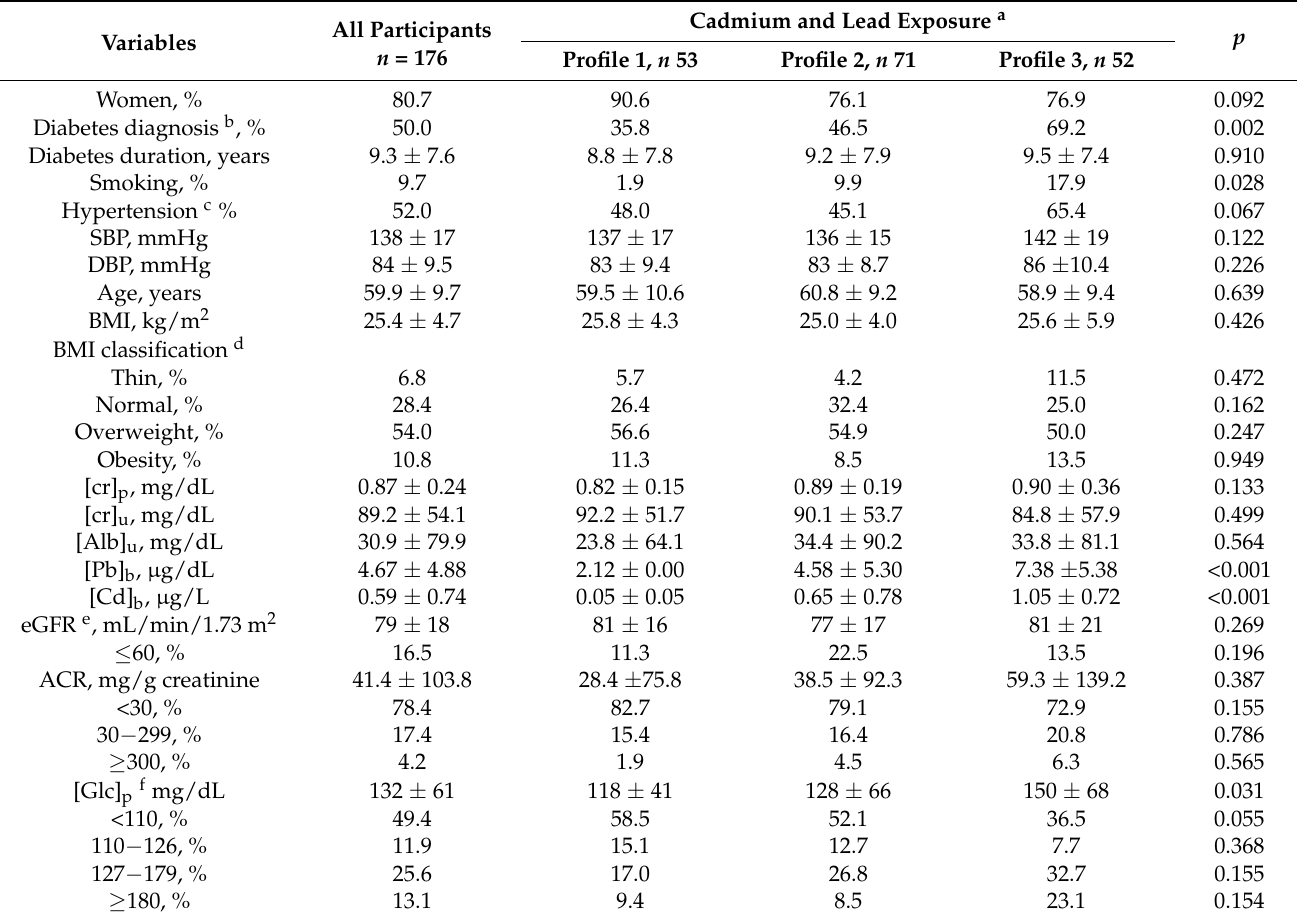
Table 1. Characteristics of participants grouped by their cadmium and lead exposure